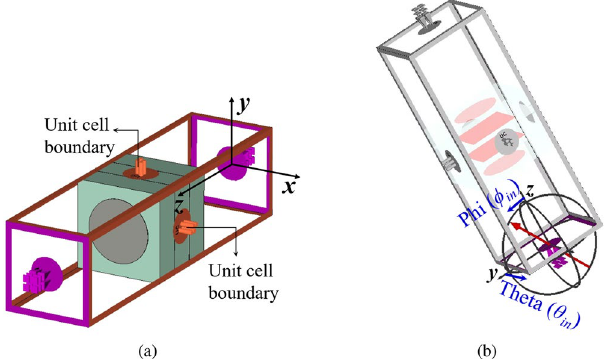
Figure 3. Simulation set-up for a PTC for the upper PGM in a NFMS system. ( a ) Perspective view of a square metal patch PTC with unit cell boundary conditions and ( b ) incidence plane wave direction defined by θ in and φ in